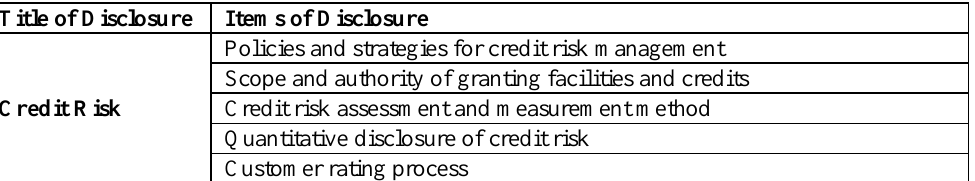
Table 1.Legal requirements of Iran for risk disclosure index Items of Disclosure Title of